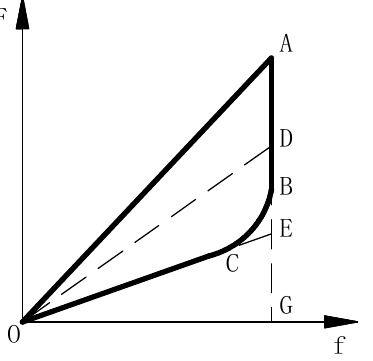
Figure 2. Load–displacement curve of ring spring.